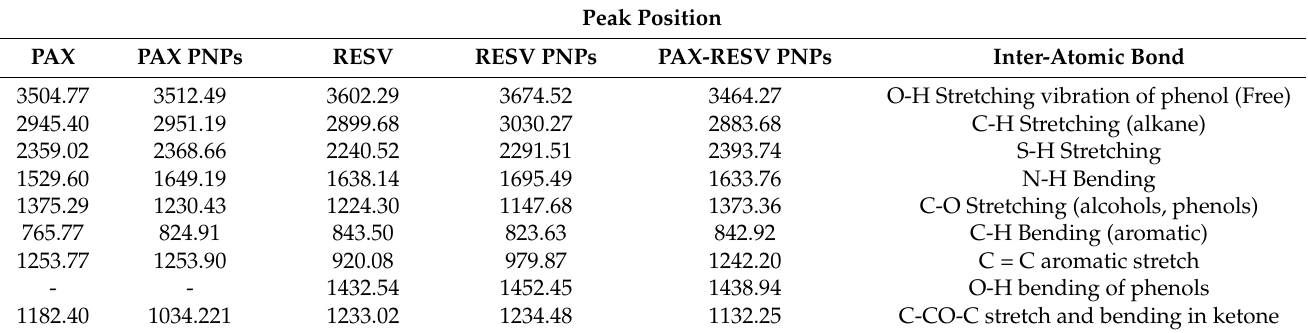
Table 3. FT-IR Spectrum of Pure PAX, RESV, Placebo, PAX, RESV PNPs and PAX-RESV